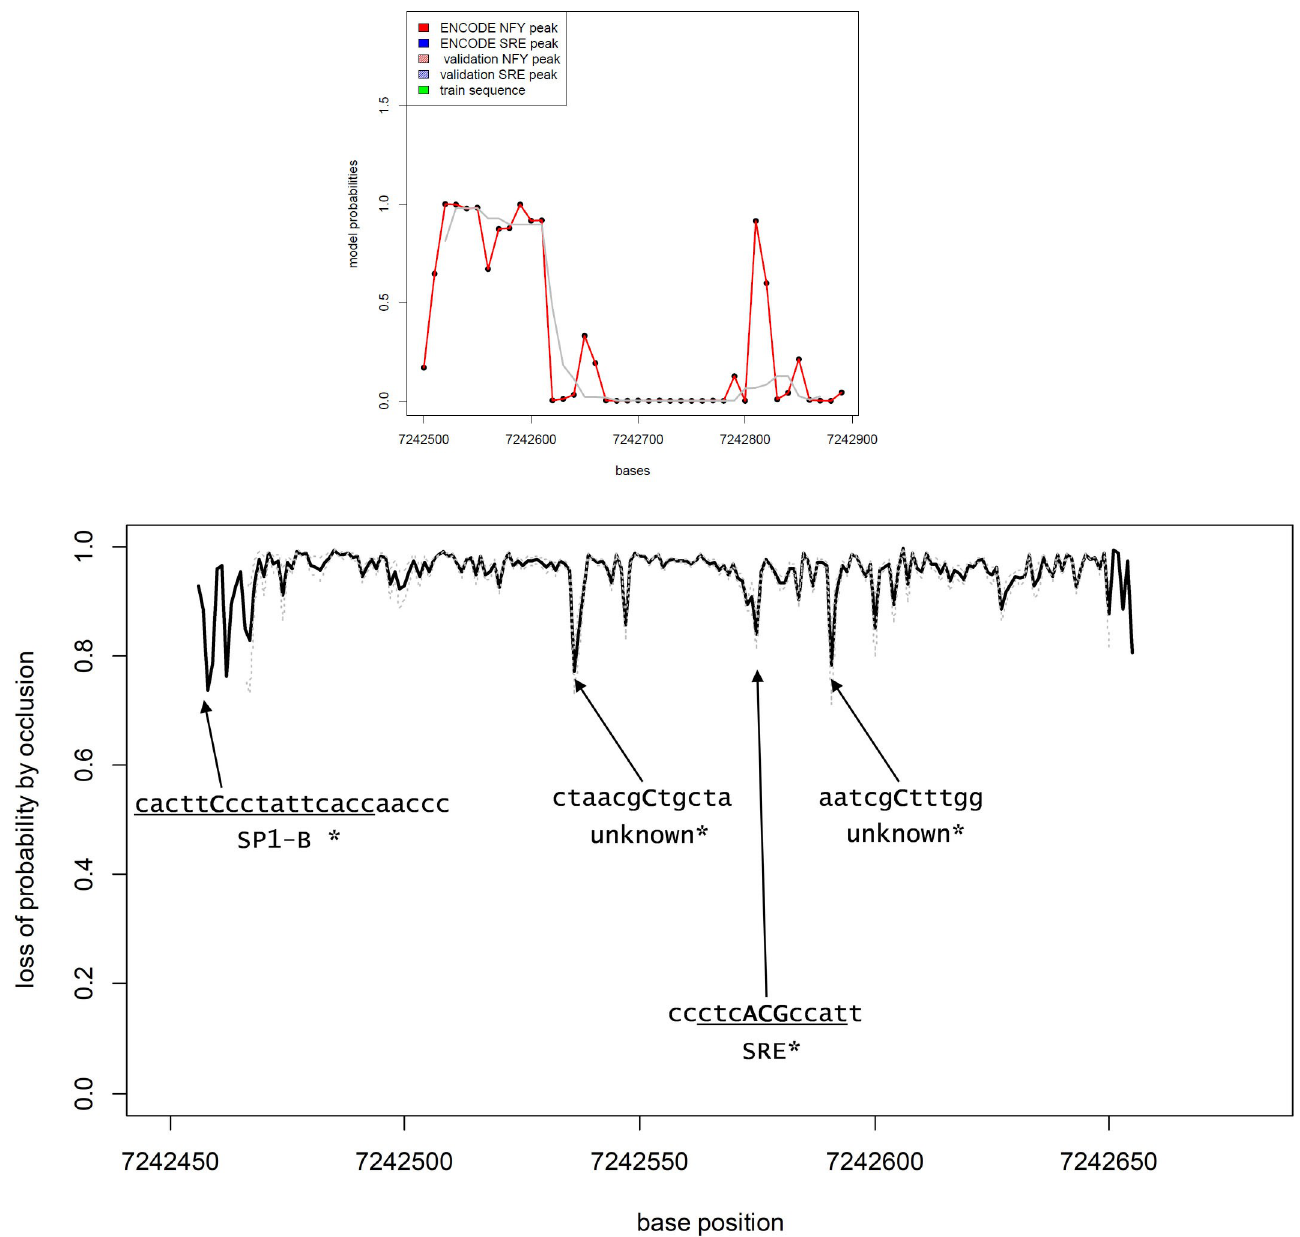
Fig 4. Evaluation of the GABARAP promoter by the CNN 1-D